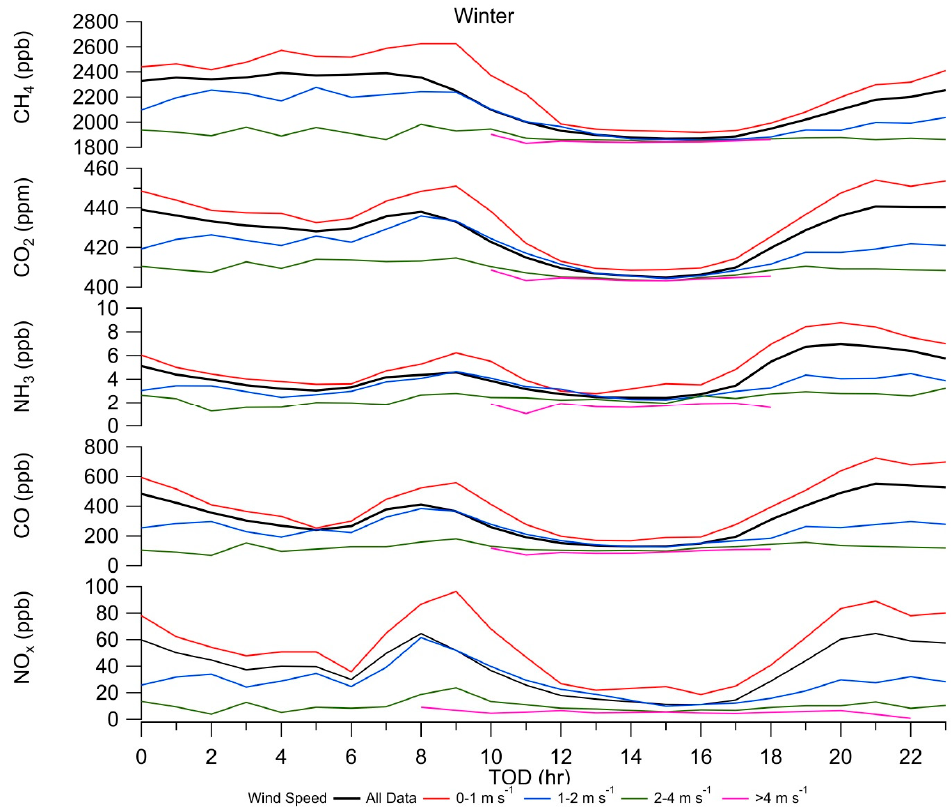
Figure 5. The variation in CH 4 (ppbv), CO 2 (ppbv), NH 3 (ppbv), CO (ppbv) and NO x (ppbv) with the hour ‐ of ‐ day and binned to wind speeds 0–1 m s − 1 , 1–2 m s − 1 , 2–4 m s − 1 , >4 m s − 1 and averaged for all hour-of-day and binned to wind speeds 0–1 m s − 1 , 1–2 m s − 1 , 2–4 m s − 1 , > 4 m s − 1 and averaged for